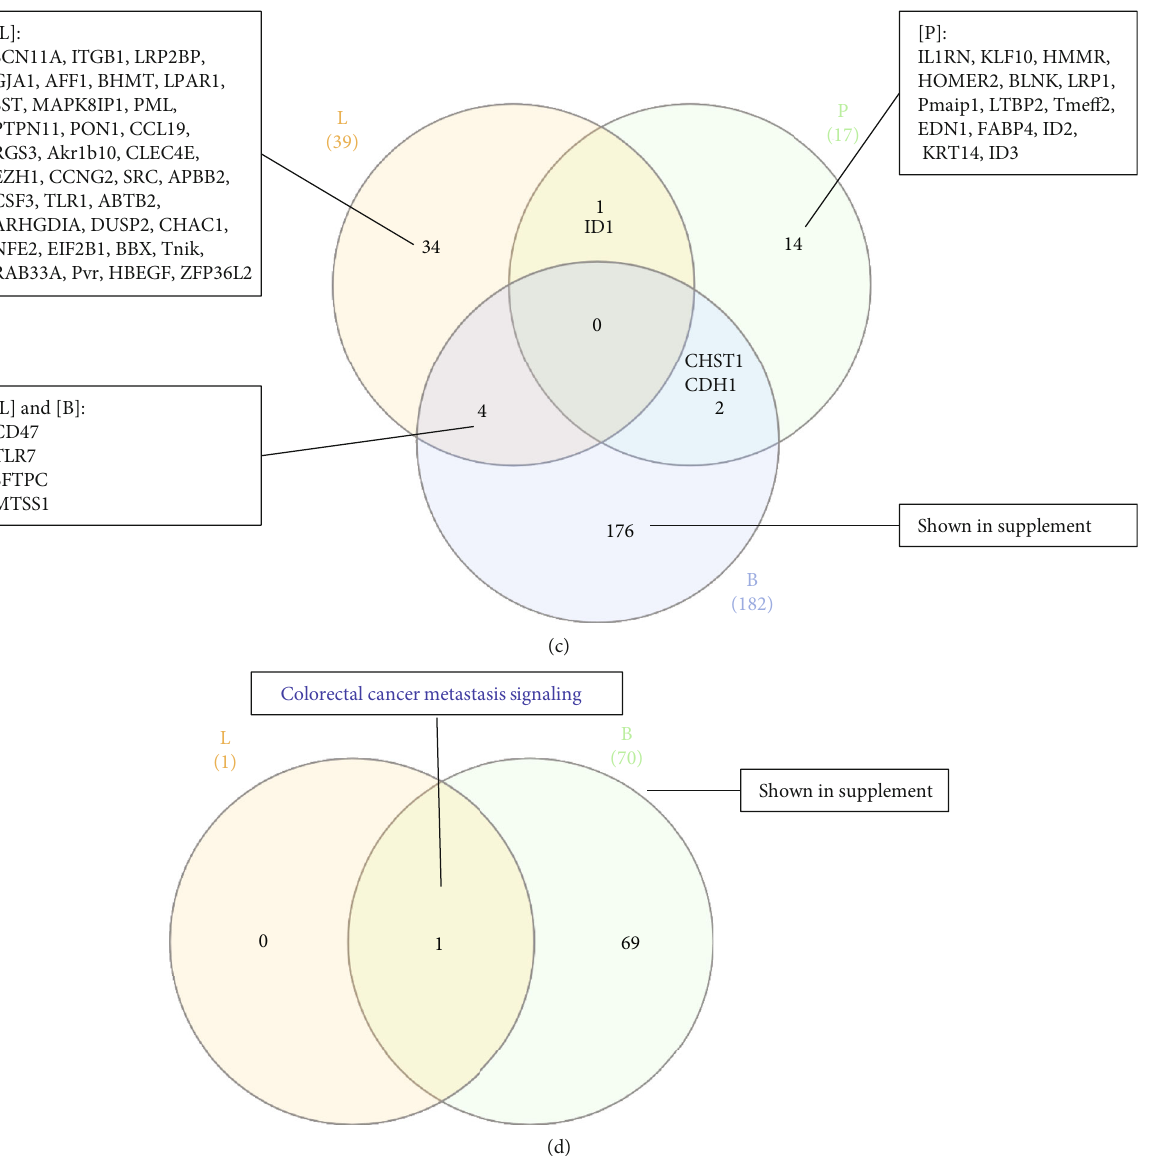
Figure 4: (a) The Venn Diagram analyses shows that LIUS-upregulated innatomic genes in three cell types are partially shared. The three genes shared by lymphoma cells (L) and preosteoblasts (P) and the 11 genes shared by lymphoma cells (L) and bone marrow cells (B) may be used for LIUS therapeutic markers. However, the majority of LIUS-upregulated innatomic genes are cell type speci fi c. (b) The Venn Diagram analyses shows that the signaling pathways involved in LIUS-upregulated innatomic genes in three cell types are partially shared, such as metastasis signaling. In addition, three pathways are shared by LIUS-treated lymphoma cells and bone marrow cells including leukocyte extravasation, osteoarthritis pathway, and cardiac hypertrophy signaling. However, the majority of LIUS-upregulated innatomic pathways in lymphoma and bone marrow cells are cell type speci fi c. (c) The Venn Diagram analyses shows that LIUS- downregulated innatomic genes in three cell types are not shared. The majority of LIUS-downregulated innatomic genes are cell type speci fi c (L: lymphoma cells; B: bone marrow cells; P: preosteoblasts). (d) The Venn Diagram analysis shows that the signaling pathways involved in LIUS-downregulated innatomic genes in lymphoma cells and bone marrow cells are partially shared, such as metastasis signaling. However, the majority of LIUS-downregulated innatomic pathways in bone marrow cells are cell type speci fi